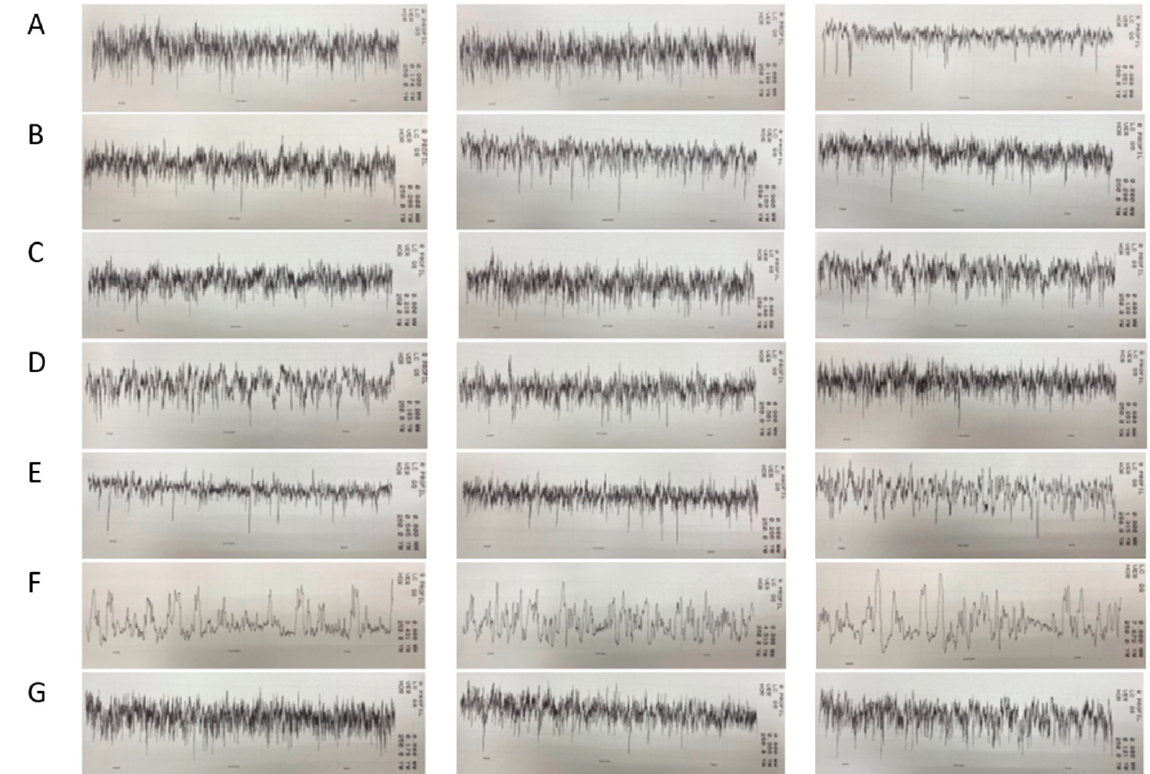
Figure 1. Surface roughness profiles for the first, third and fifth sample within each group ( A – G ). The Shapiro–Wilk test shows that the data distribution for the two roughness data sets Ra (arithmetic average roughness value) and Rz (mean roughness depth) does not deviate significantly from the normal distribution (Tables 2 and 3, p > 0.05). Levene’s test shows significant inhomogeneity of variances ( p (Rz) = 0.0165; p (Rz) = 0.0173). The data were logarithmised to compensate for the variances. With logarithmised data, the variability of the standard deviation is lower. According to the Levene test for logarithmised data, the homogeneity of the variances was confirmed ( p (Ra) = 0.08 i p (Rz) =